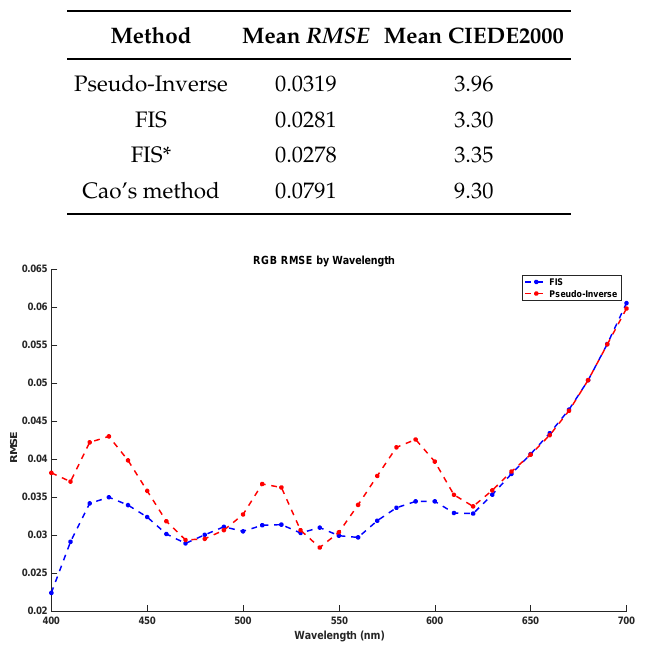
Table 4. Performance in spectral recovery from RGB for the reference methods and the build FIS method. We also include the FIS* variant where the outputs multi-clusterization option is considered.